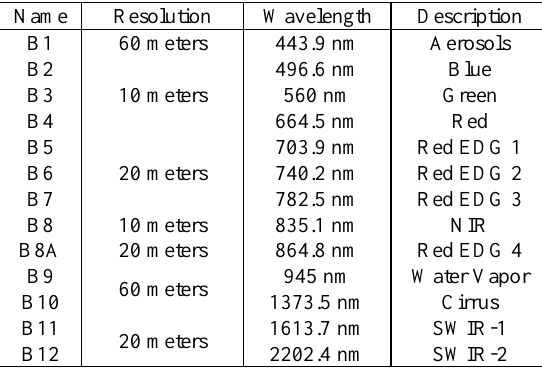
Table 1. Characteristics of the Sentinel-2A MSI